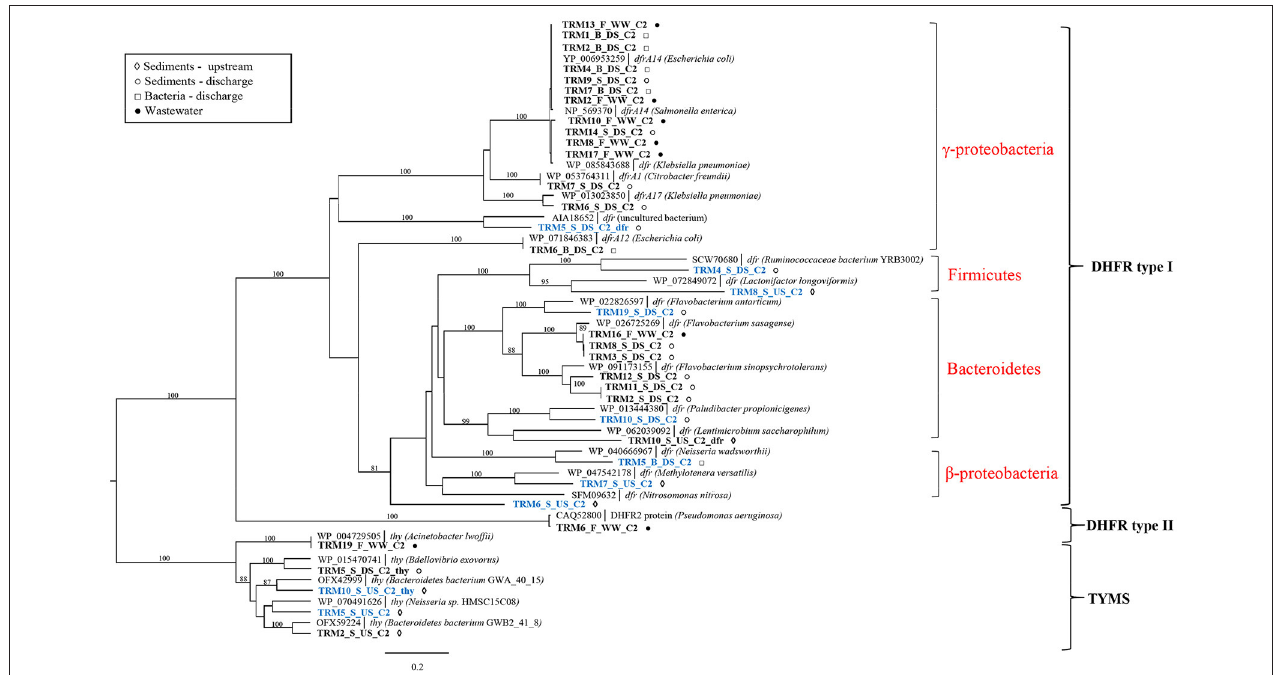
FIGURE 2 | Phylogenetic tree of protein sequences of TRM resistance genes. Best BLAST hits and representative protein sequences of the studied genes were retrieved from the NCBI database. The evolutionary history was inferred by using the maximum likelihood method and the Geneious software. Bootstrap values were calculated on 100 replications and only those higher than 80% are shown. Sequences that share ≤ 80% amino acid identity with proteins in the NCBI database are shown in blue. Scale bar = 0.2 changes/site.